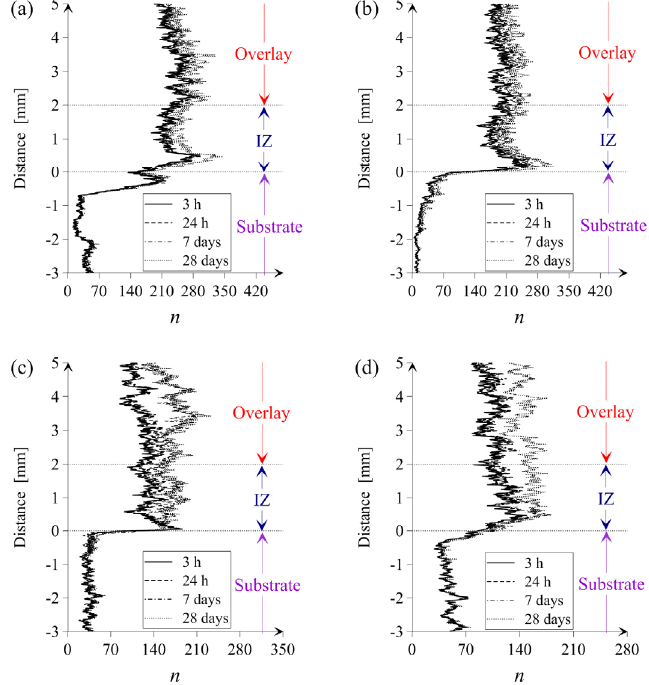
Figure 7. The number of pores n as a function along a sample height obtained within the IZ between the overlay made of cement mortar and the existing concrete substrate obtained by the micro-CT method at different moments of overlay hardening for Samples ( a ) T1; ( b ) T2; ( c ) T3; and ( d ) T4.